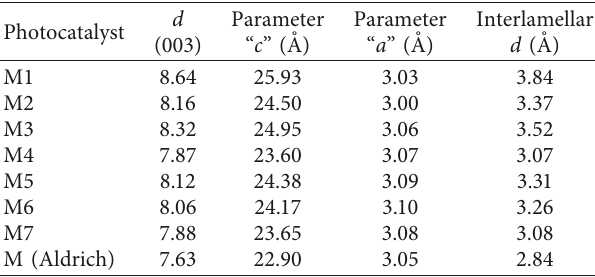
Figure 1: X ray diffraction of fresh Mg/Al hydrotalcites with different Mg/Al Table 1: Network parameters of hydrotalcite-type photocatalysts M1 to M7.